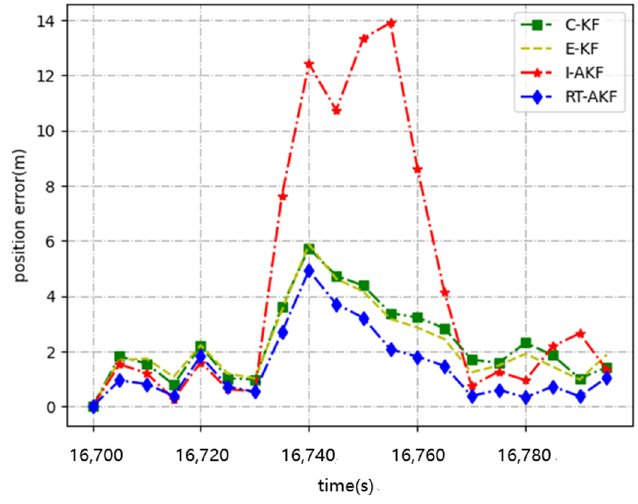
Figure 12. The positioning errors of GNSS/INS tightly coupled integrated by different methods in segment #3.